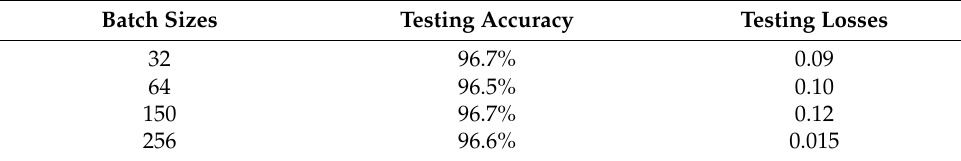
Table 4. Testing accuracy and testing losses for multiple batch sizes values.